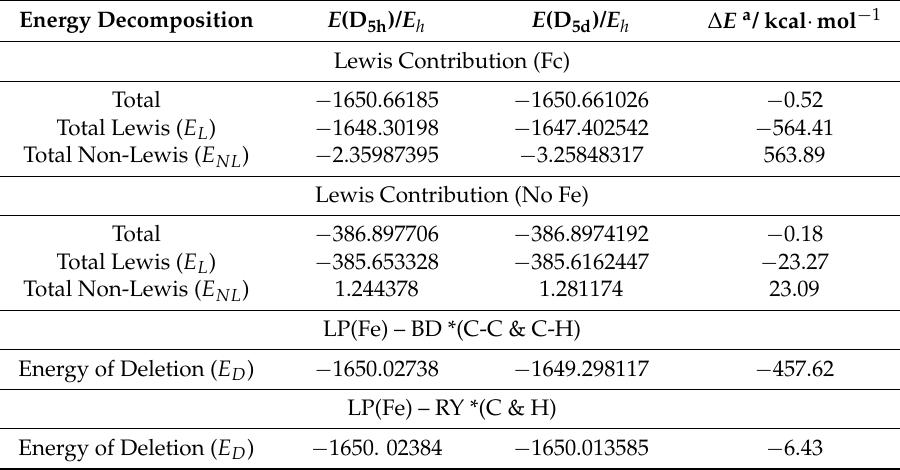
Table 5. NBO Analysis of ferrocene conformational differences